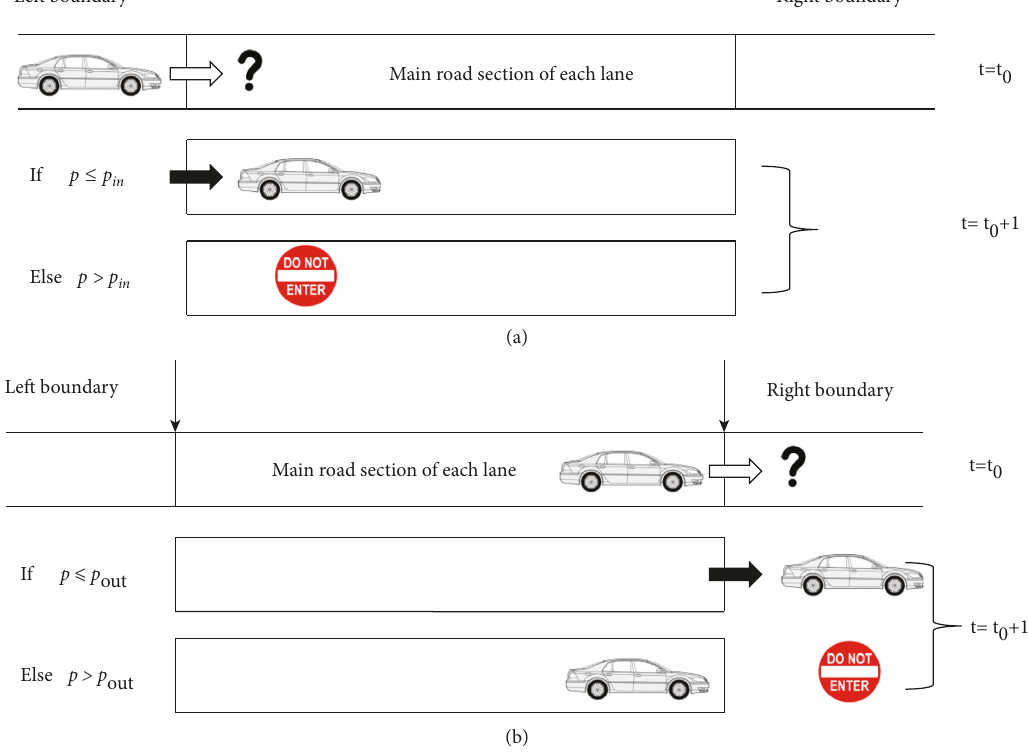
Figure 2: Vehicle movements rules. (a) Vehicle movements at the left boundary. (b) Vehicle movements at the right